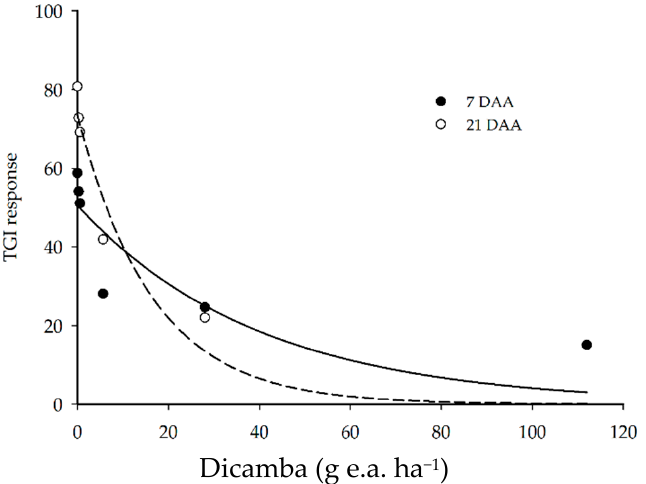
Figure 3. Soybean TGI responses at 7 and 21 DAA of dicamba doses. On the other hand, the application of up to 5.6 g e.a. ha − 1 of dicamba at 21 DAA gen- erated higher TGI values, as compared to 7 DAA, indicating plant development and recovery from the injury caused by the herbicide. The application of 28 and 112 g e.a. ha − 1 of dicamba at 21 DAA further decreased the TGI responses, with reductions of 73 and 110% as compared to the control (0 g e.a. ha − 1 of dicamba), respectively.